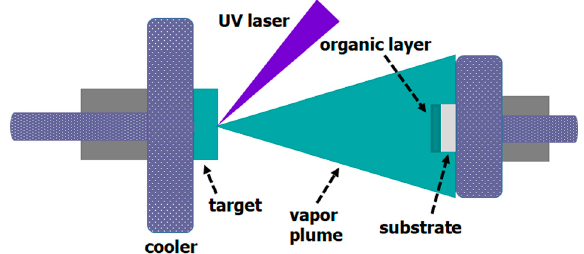
Scheme 1. Schematic representation of the MAPLE set-up used for the deposition of the organic layers.